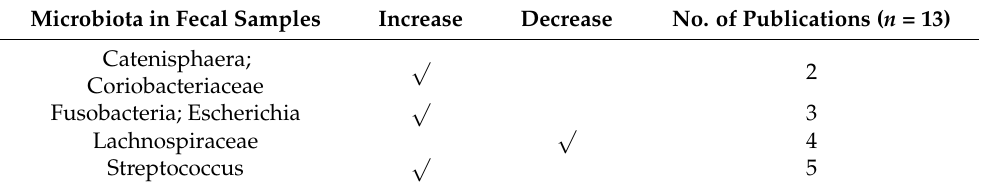
Table 4. Changes in microbiota populations in fecal samples of CHD patients.